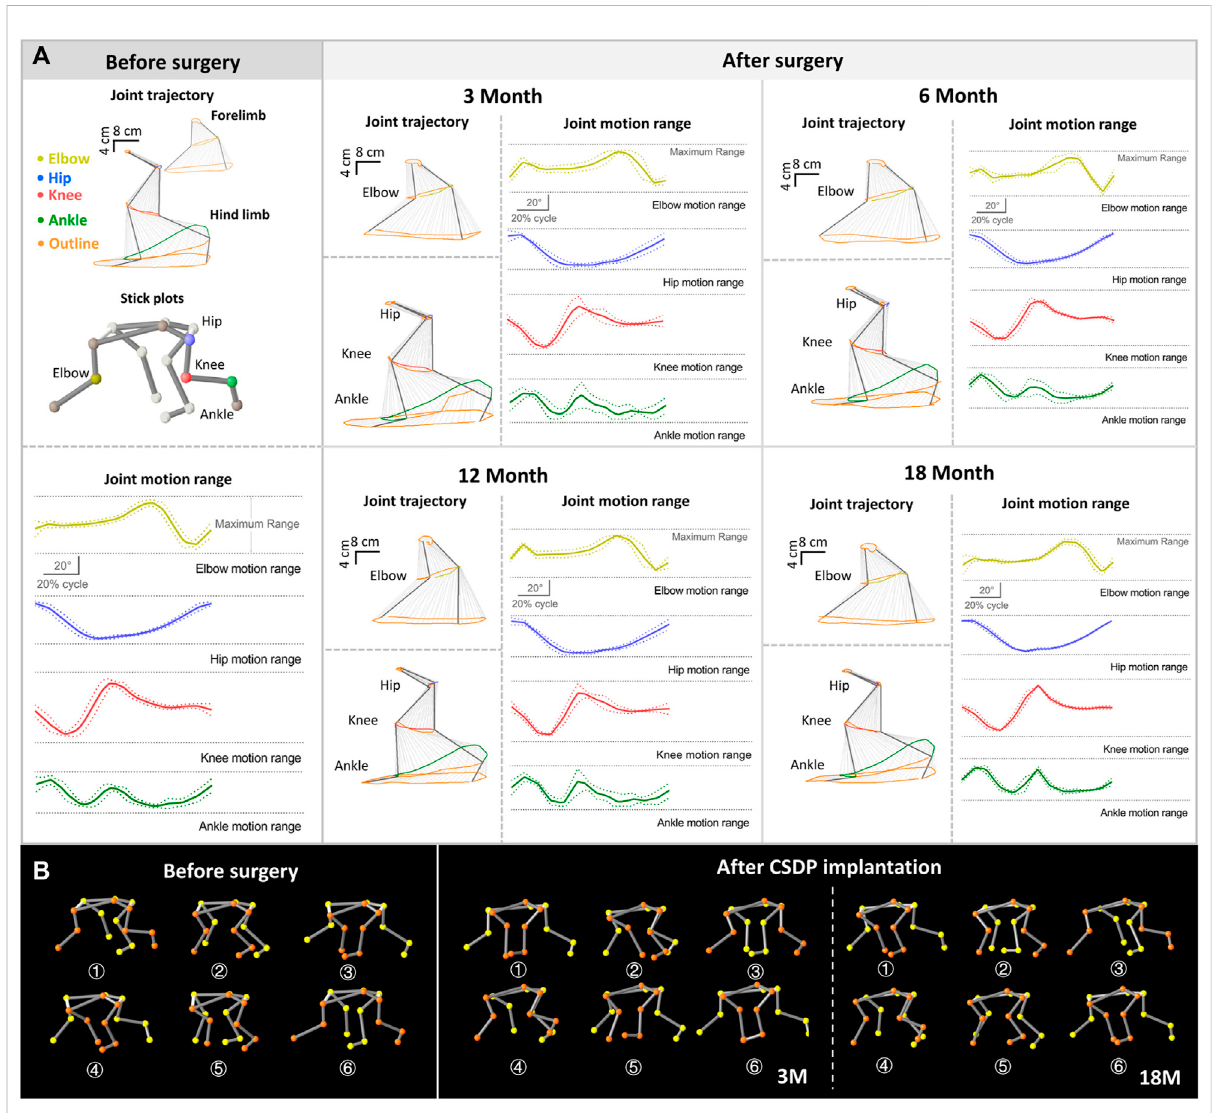
FIGURE 6 Kinematic analysis of limbs and joint trajectory situation in non-human primates. (A) The joint trajectory and joint motion range analysis at 1 month before surgery and 3, 12, and 18 months after surgery. (B) The kinematic analysis 3D-stick plot models pre and post-operation, describing the basic situation of the joint